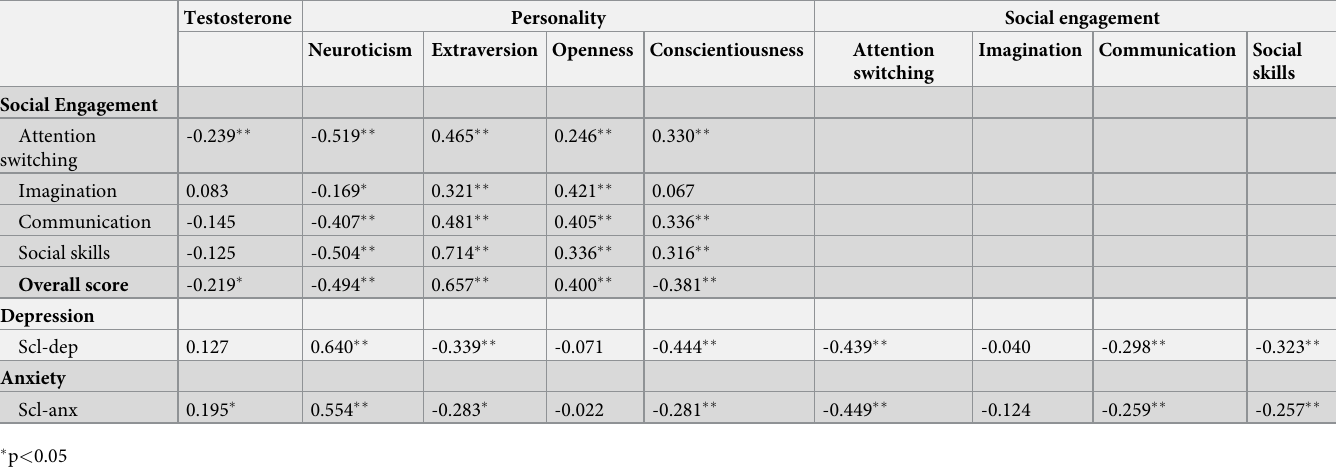
Table 2. Correlations between testosterone, personality traits, social engagement skills, anxiety and depression.